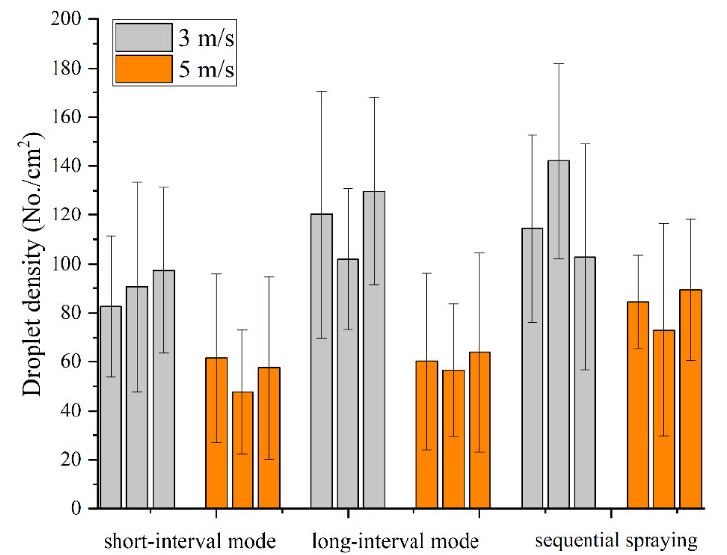
Figure 19. The results of droplet density in spray overlapping area.